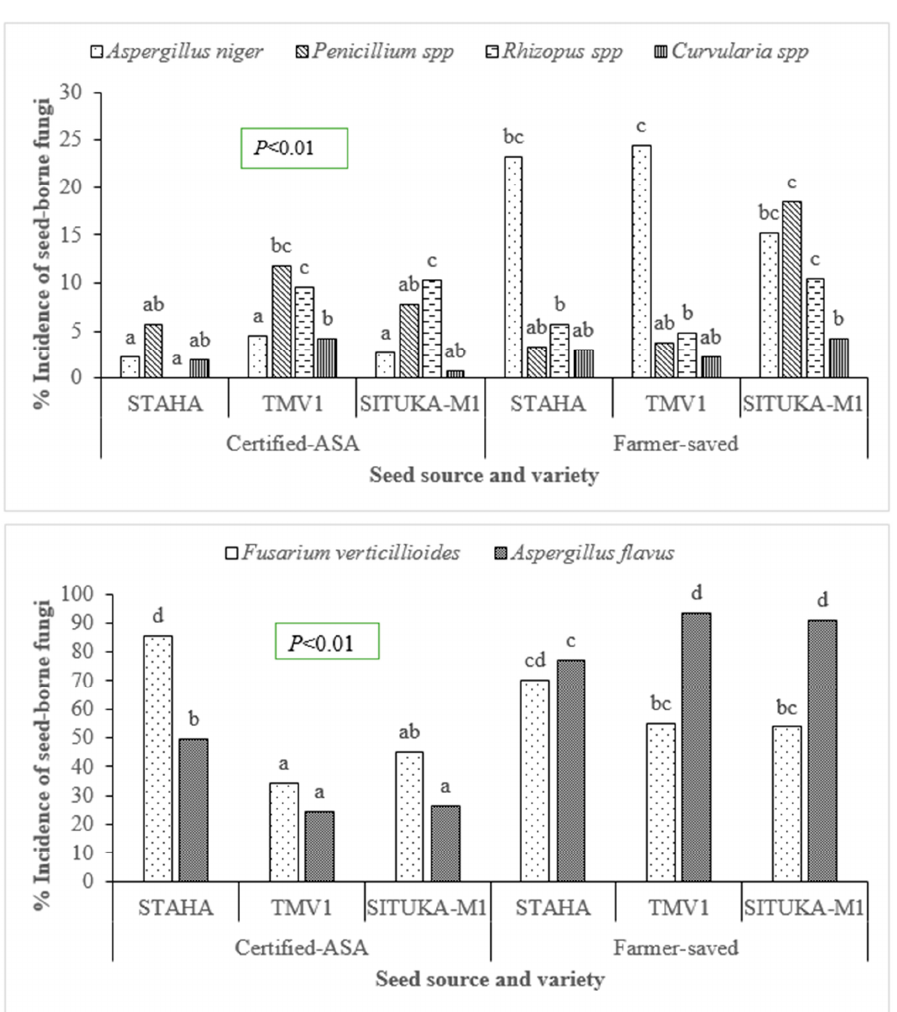
Figure 5. Fungal incidences. Means with the same letters along the same bars are not significantly different ( p < 0.05). 3.2. Inhibition of Fungal (F. Verticillioides) Mycelial Growth Fungal mycelial growth is 100% inhibited by all ethanol-extracted bio-fungicides while the inhibitory effects of water-extracted bio-fungicides vary with the type of plant extract. For the water-extracted bio fungicides, the highest inhibition is achieved with neem (55.88%), followed by ginger (46.31%), and lastly coffee (5.15%). The positive control, Apron Star ® 42 WS, has 100% mycelial growth inhibition (Figure 6).